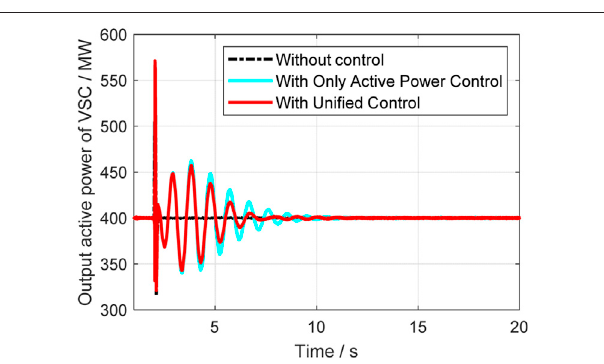
FIGURE 22 | Active power of VSC with different schemes.